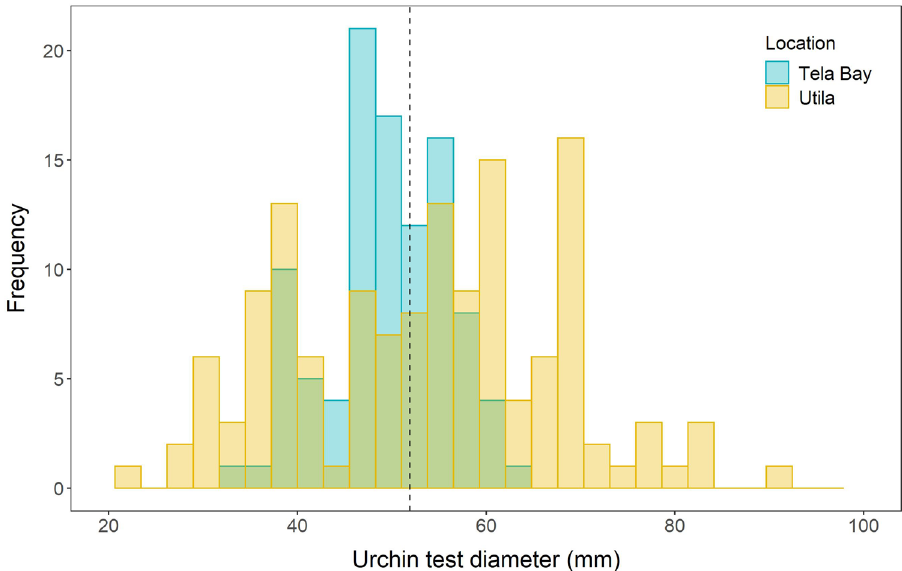
Figure 3. Distribution of adult D. antillarum test diameters on the reefs of Utila (yellow; n = 139) and Tela (blue; n = 100). Dotted vertical line is the mean of all individuals from both locations.